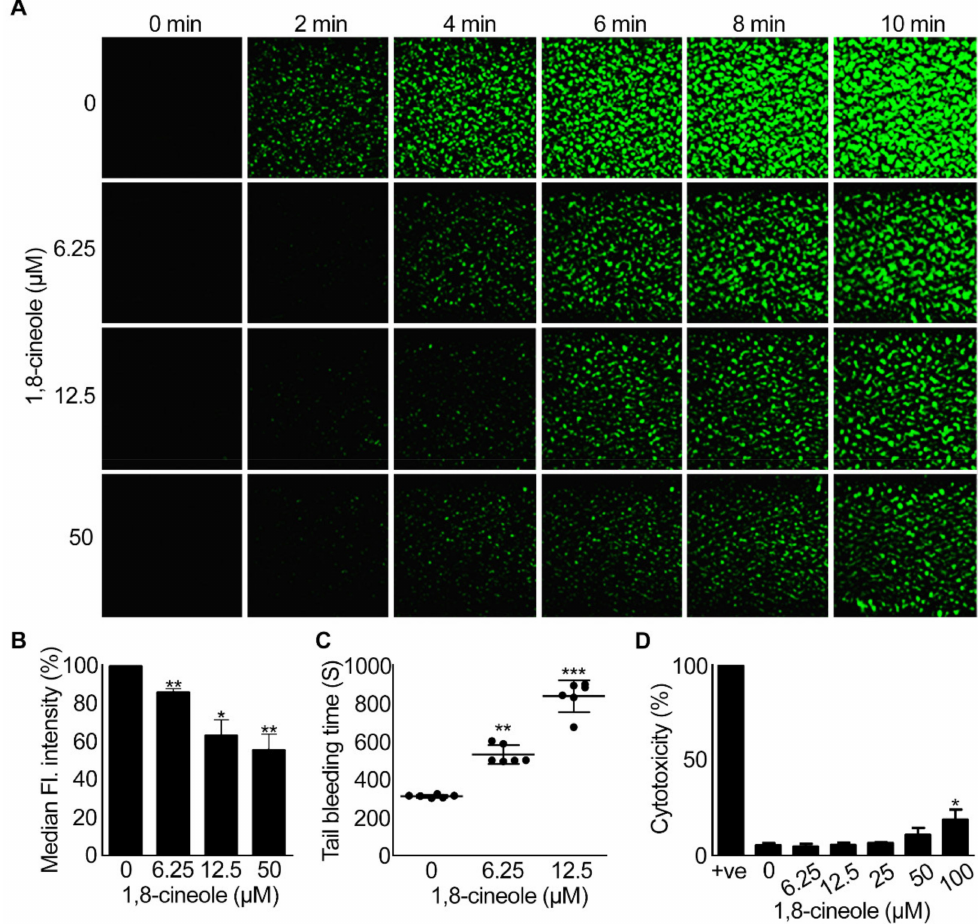
Figure 8. Impact of 1,8-cineole on thrombus formation and haemostasis. DiOC6 (a lipophilic dye) (5 µ M)-labelled human whole blood was incubated with a vehicle or different concentrations of 1,8-cineole for 5 min and perfused through microfluidic channels (Vena8 BioChips) coated with collagen (400 µ g/mL). Thrombus formation was observed using a 20 × objective on a Nikon A1-R confocal microscope, with images captured every 30 s up to 10 min ( A ). Quantified data represent median fluorescence intensity of thrombi formed at 10 min in control and 1,8-cineole-treated samples as calculated using NIS elements software (Nikon) and normalised to the level of median fluorescence intensity obtained for thrombi at 10 min in the vehicle treated sample ( B ). Data represents mean ± SEM ( n = 3). The p values (* p < 0.05, and ** p < 0.01) shown are as calculated by one-way ANOVA with Dunnett’s post hoc test. ( C ) Effect of 1,8-cineole on haemostasis in mice was analysed using a tail bleeding assay. Mice ( n = 6 per group) were anaesthetised and a vehicle control [0.01% ( v/v ) ethanol] or 1,8-cineole (6.25 µ M or 12.5 µ M) was administered via femoral artery. After 5minutes of incubation, 3 mm of tail tip was dissected, and the tail tip was placed in sterile PBS. The time for cessation of bleeding was measured up to 20minutes. Data represent mean ± SEM ( n = 6). The p values shown (** p < 0.01 and *** p < 0.001) are as calculated by non-parametric Kruskal–Wallis test. ( D ) To determine whether 1,8-cineole exerts any cytotoxic effects on human platelets, human isolated platelets were exposed to a positive control, a vehicle control [0.1% ( v/v ) ethanol] or various concentrations of 1,8-cineole for 30 min and the amount of LDH released (a marker for cytotoxicity) was measured at 490 nm and 650 nm using spectrophotometry. The maximum LDH release obtained with the positive control was taken as 100% and the level of LDH release for 1,8-cineole treated samples was calculated accordingly. Data represent mean ± SEM ( n = 3). The p value shown (* p < 0.05) was calculated by one-way ANOVA with post hoc Dunnett’s